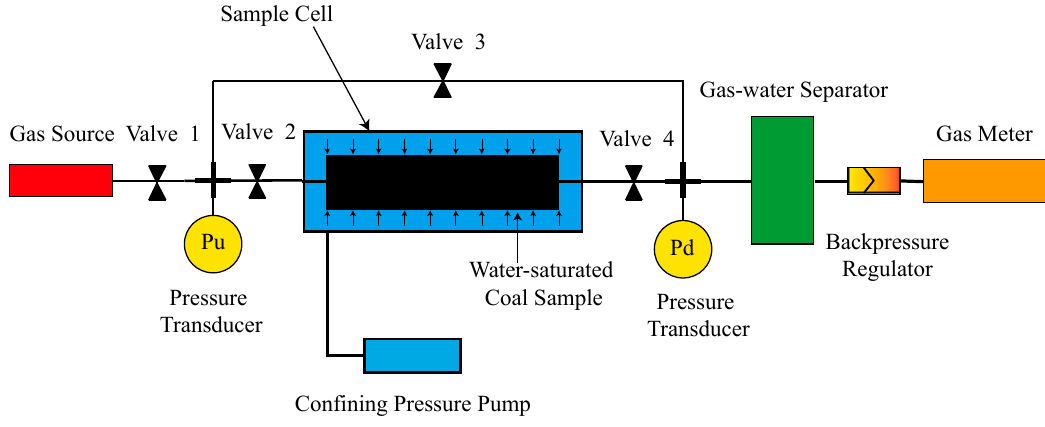
Figure 5. The principle of unsteady-state measurement.